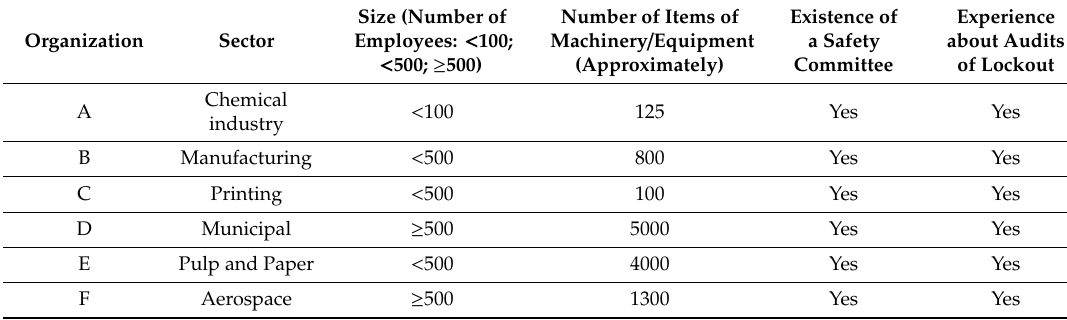
Table 3. General information about the six organizations in the